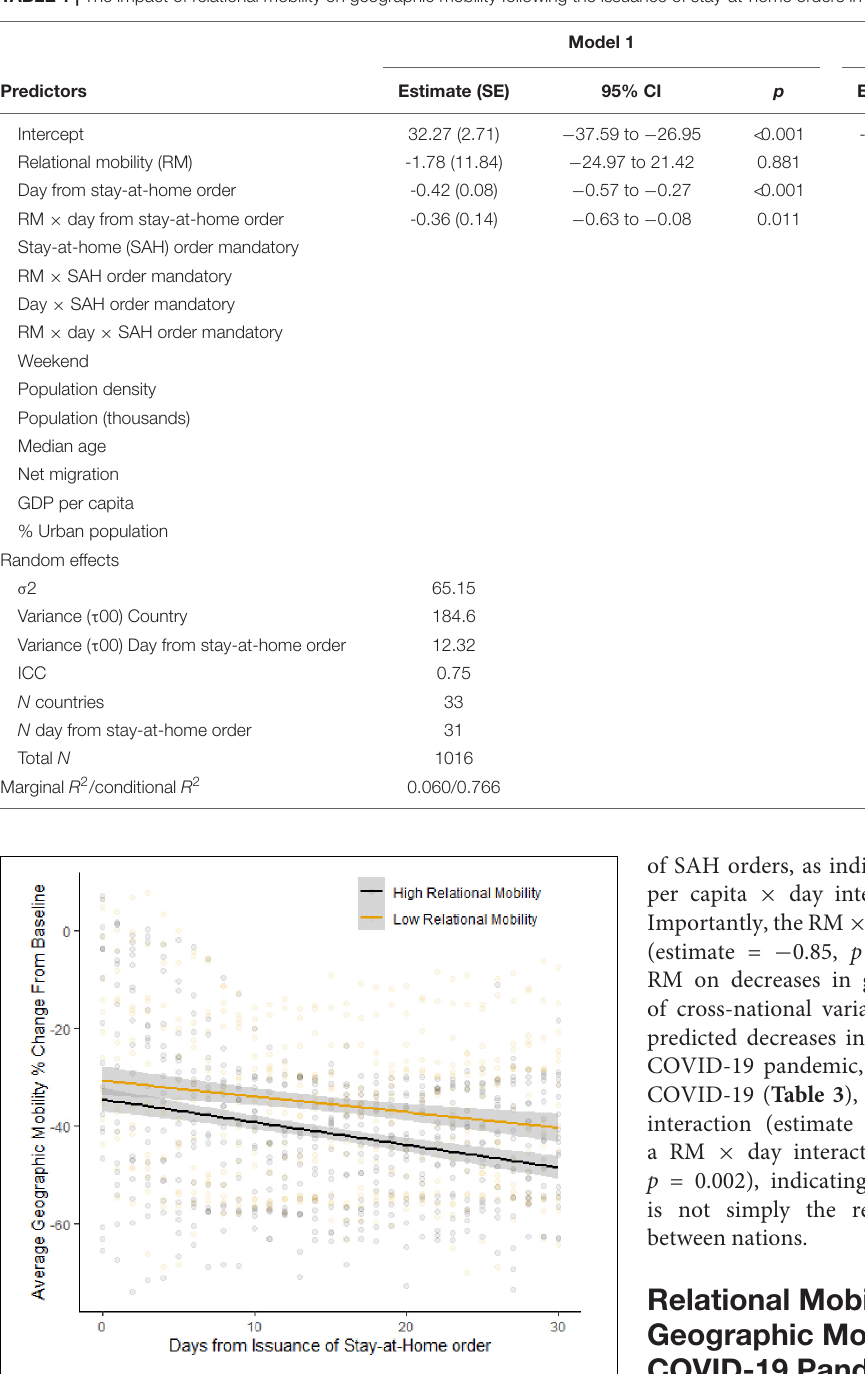
TABLE 1 | The impact of relational mobility on geographic mobility following the issuance of stay-at-home orders in each country.